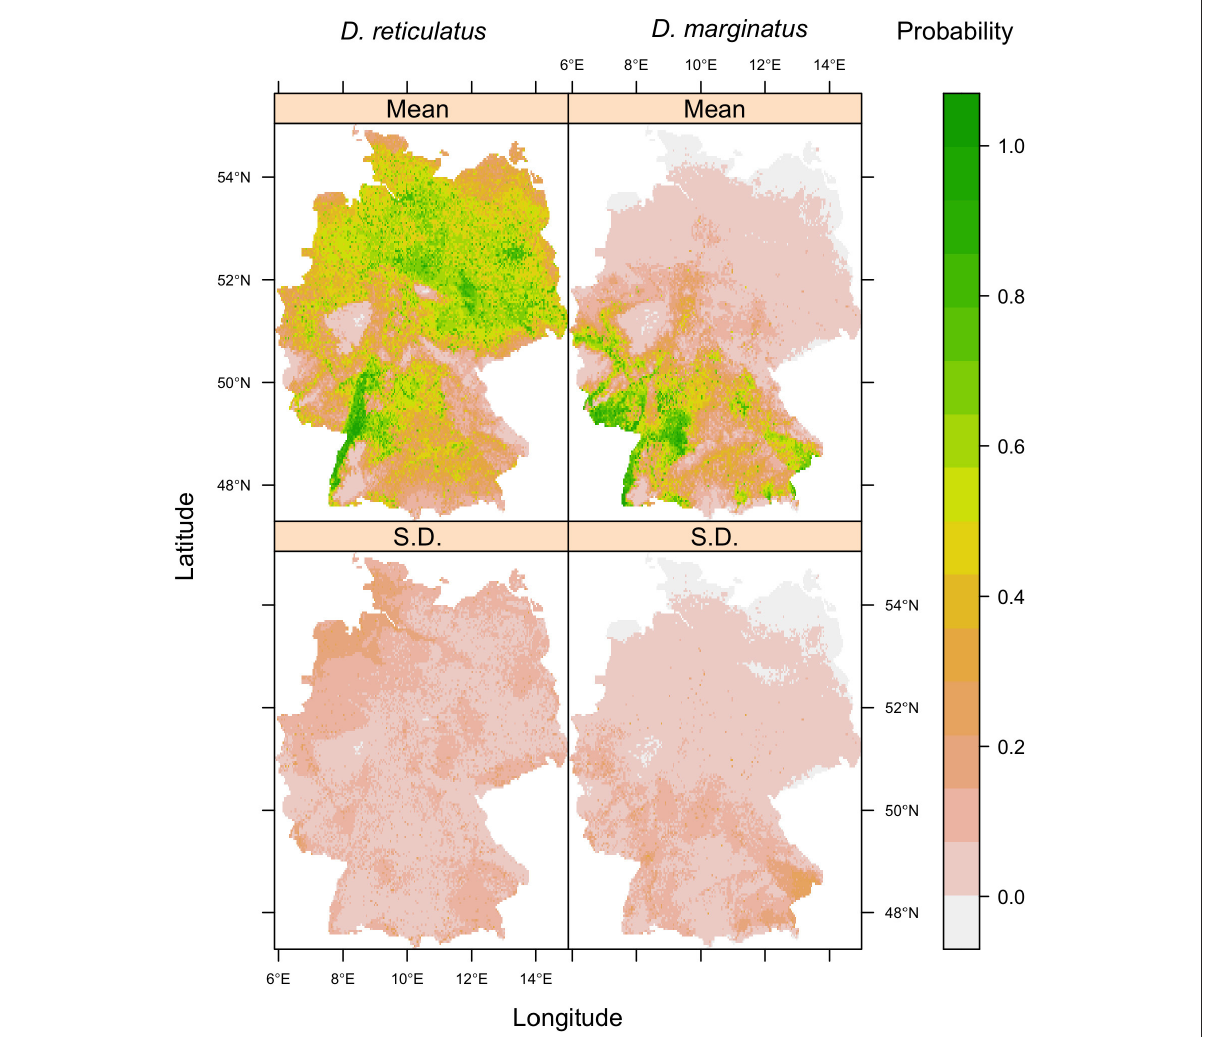
FIGURE6 Mean (top row) and standard deviation (bottom row) of 10 Maxent model replicates for D. reticulatus (left column) and D. marginatus (right column). Model predictions represent the predicted environmental suitability for each species, whereby 0 indicates low potential environmental suitability and 1 indicates a high potential environmental suitability. The threshold probability which maximized sensitivity and specificity was 0.46 (0.11S.D.) for D. reticulatus and 0.24 (0.06) for D. marginatus . Each replicate was run using a random 70% subset of the occurrence and pseudoabsence